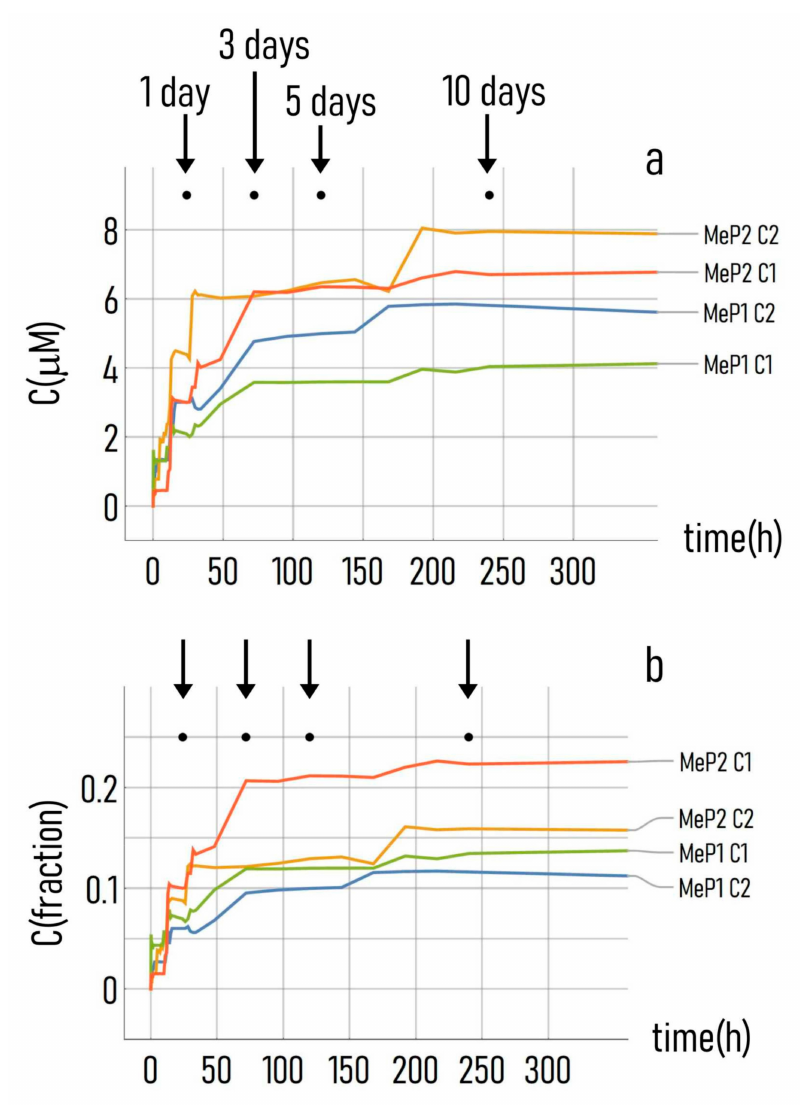
Figure 7. ( a ) Absolute and ( b ) normalized release profile of the anti-tumor drug PtCl ( O , O (cid:48) − acac )( DMSO ) measured for MeP 1 and MeP 2 substrates up to 15 days from the beginning of the